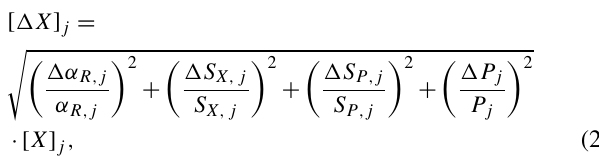
Figure 1. Inferred absorption spectra of CH 2 O (a–f) , C 2 H 2 O 2 (g–l) , and C 3 H 4 O ∗ 14:53UTC, respectively, during the flight on 11 September 2014 (AC11). The traces shown in blue are the inferred atmospheric spectra together with the residual spectral structures; the red line shows the reference spectra of the respective gases. In order to avoid cross corre- lations with the 7 ν absorption band of H 2 O at 442nm, C 2 H 2 O 2 is simultaneously fitted over two separated spectral windows, ranging from 420 to 439 and 447 to